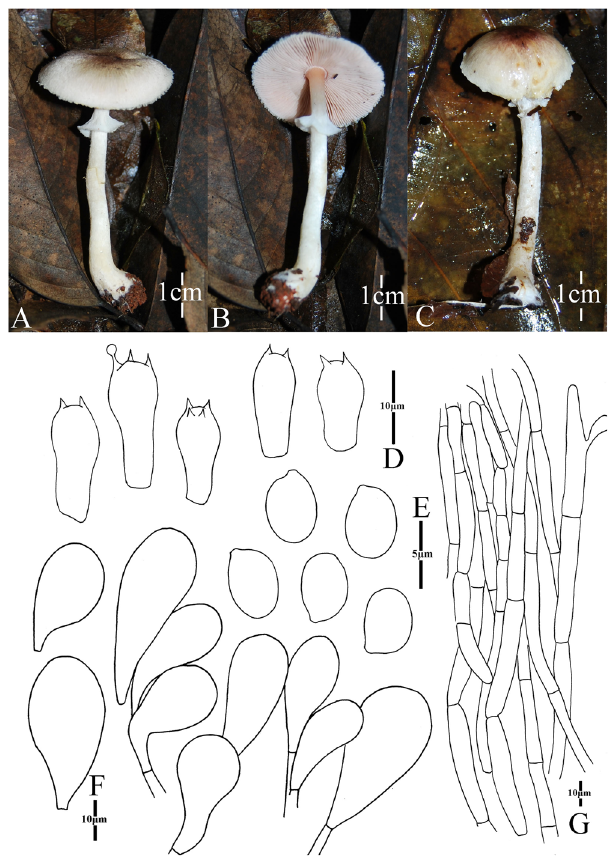
Figure 13. Morphology of Agaricus mangaoensis ( ZRL2010056 , holotype), ( A – C ): Basidiome in field ( A , B ): ZRL2010056 ; ( C ): ZRL2010073 ), ( D ): Basidia, ( E ): Basidiospores, ( F ): Cheilocystidia, and ( G ): Pileipellis